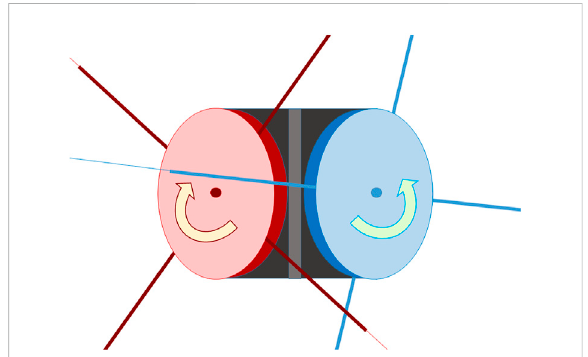
FIGURE 3 An illustration of the Twin Orthogonal Rotating Platforms (TORPs)onanon-rotatingcentralbody.TheTORPsareorientedat 90 ° degrees with respect to each other, and they are both equipped with crossed double probes (only partially shown).